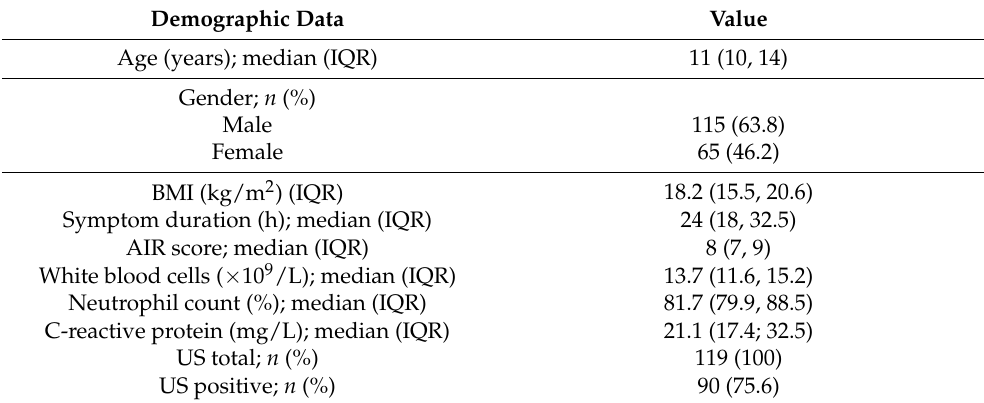
Table 2. Demographic and clinical data of the patients.